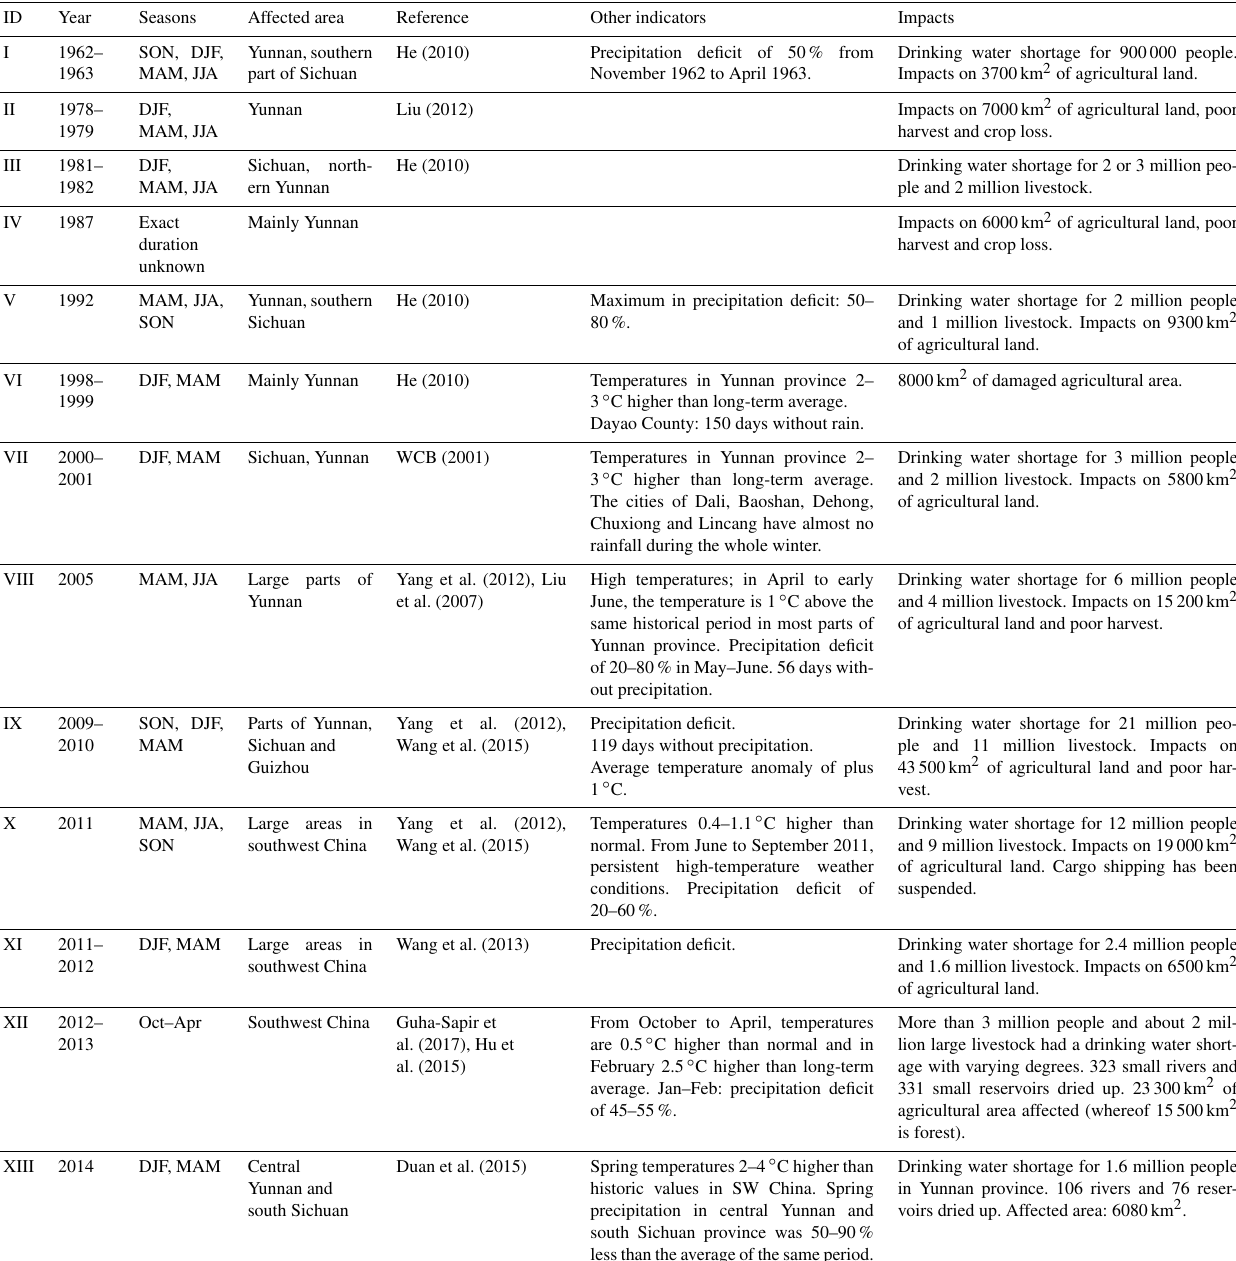
Table 1. Catalog of historical drought collected for the lower JRB (DJF: December–January–February; MAM: March–April–May;